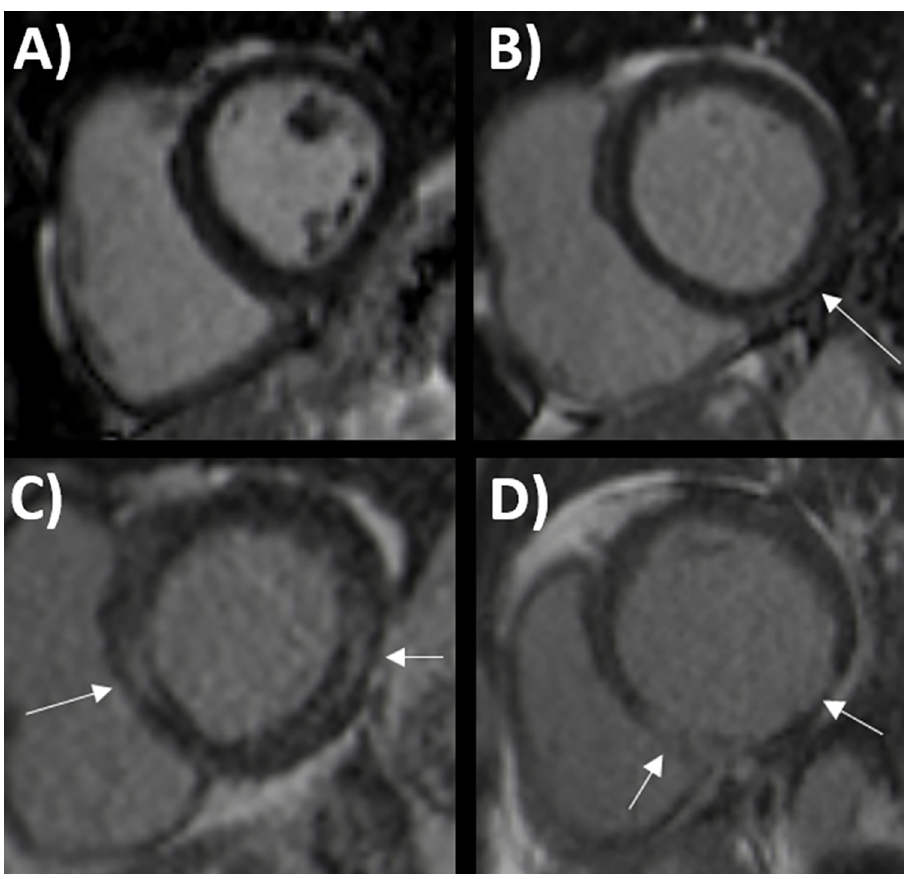
Fig 2. Examples of cardiac magnetic resonance imaging findings in patients with coronavirus disease 2019 (COVID-19). Normal left ventricle (LV) without late gadolinium enhancement (LGE) ( A ). Subepicardial LGE in inferolateral LV wall suggestive of previous myocarditis ( B ). More severe LGE with a septal and inferolateral non- ischemic pattern concordant with previous myocarditis ( C ). The inferior wall has extensive subendocardial and transmural scarring due to previous myocardial infarction ( D ). White arrow =